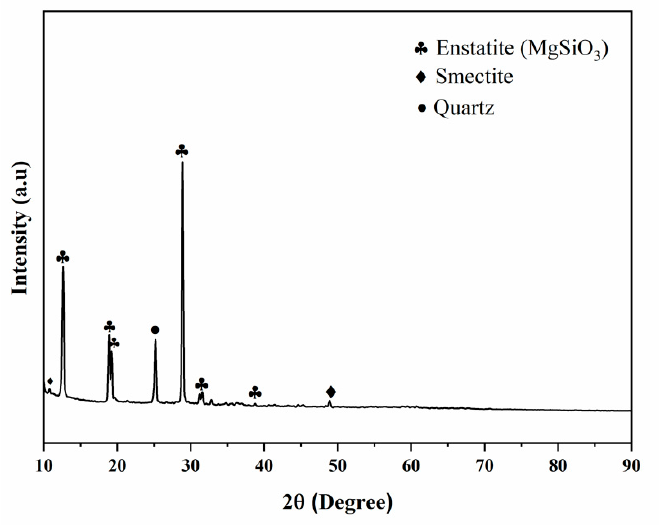
Figure 2. XRD pattern of the composites.